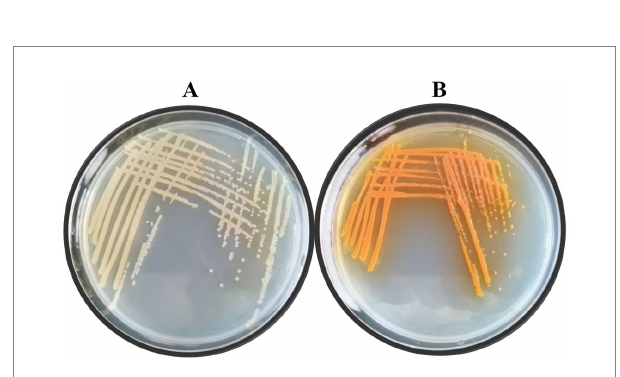
FIGURE 3 Colony morphology of different strains. (A) Pseudomonas chlororaphis LDA-4. (B) Pseudomonas chlororaphis